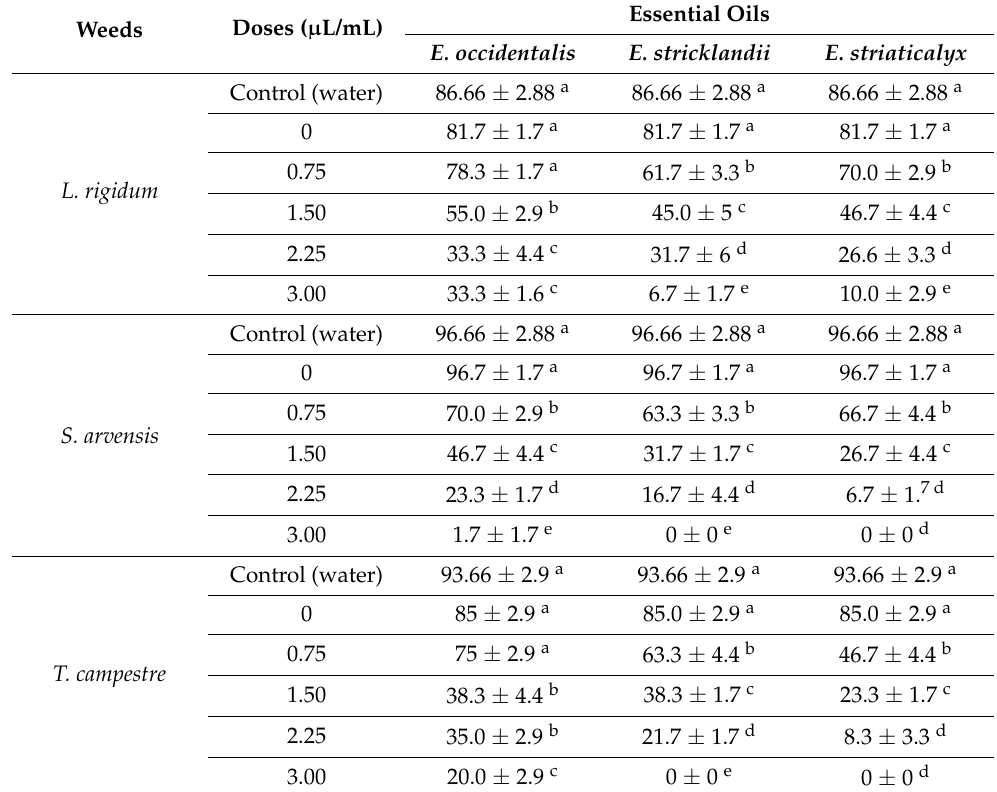
Table 2. Inhibitory effect of the EOs on percentage germination of Lolium rigidum , Sinapis arvensis and Trifolium campestre .